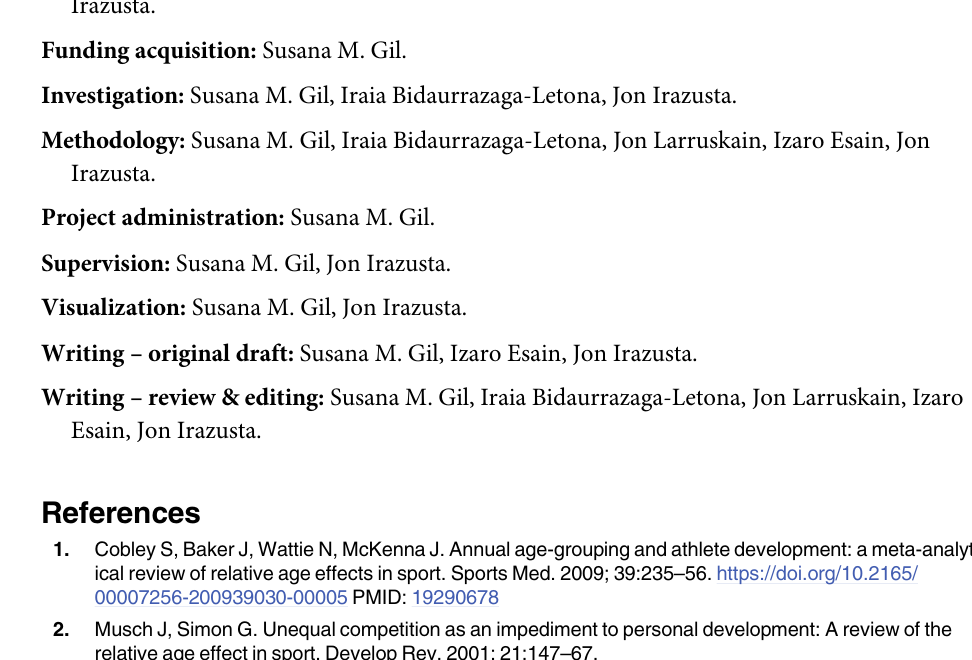
S10 Table. Descriptive statistics of the birth dates of female 10-year-old participants and the general population. S11 Table. Descriptive statistics of the birth dates of female 11-year-old participants and the general population. S12 Table. Descriptive statistics of the birth dates of female 12-year-old participants and the general population. S13 Table. Descriptive statistics of the birth dates of female 13-year-old participants and the general population. S14 Table. Descriptive statistics of the birth dates of female 14-year-old participants and the general